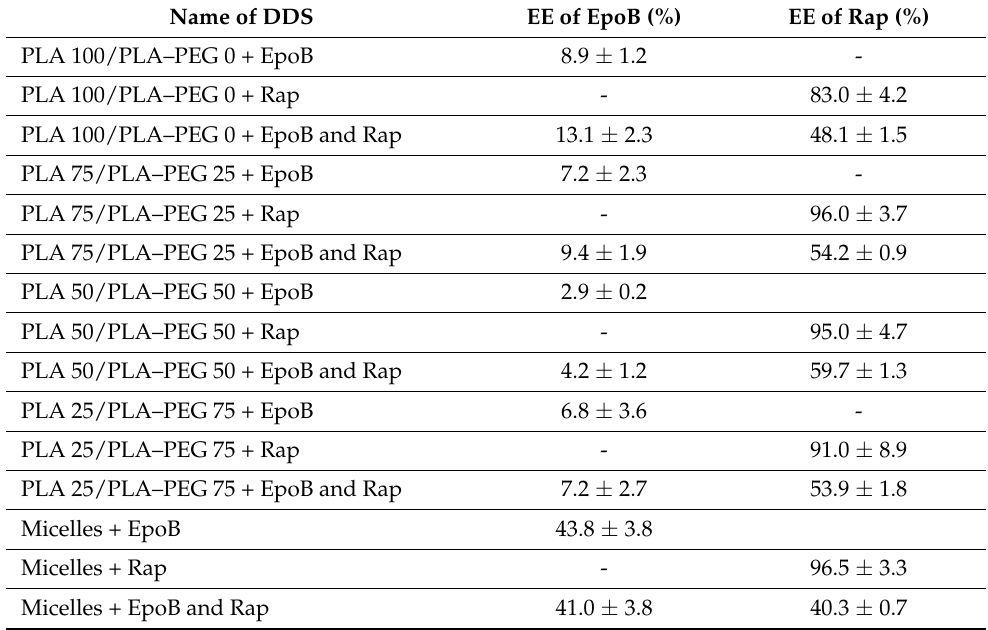
Figure 2. Morphology of drug-free ( A ) and epothilone B and rapamycin (EpoB + Rap) co-loaded micelles ( B ). Table 2. Comparison of the drug encapsulation properties of epothilone B (EpoB) and rapamycin (Rap) by various PLA-based delivery systems